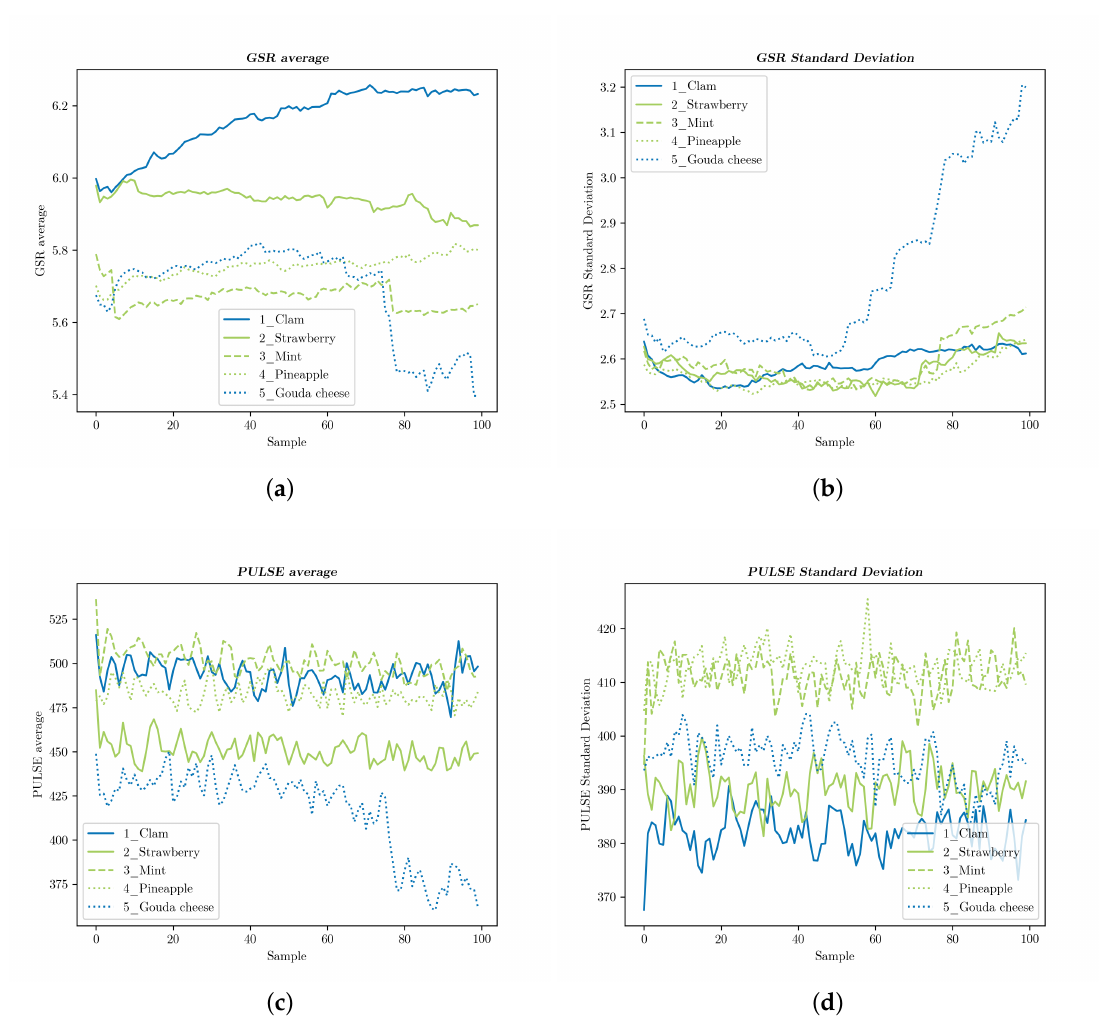
Figure 16. GSR and pulse measurements for the taste tests: ( a ) The participants’ GSR average values and ( b ) standard deviation. ( c ) The participants’ pulse average values and ( d ) standard